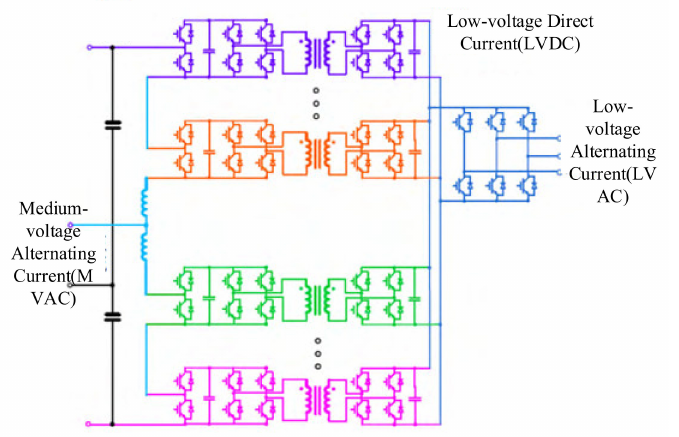
Figure 1. Topology of a typical three-port power electronic